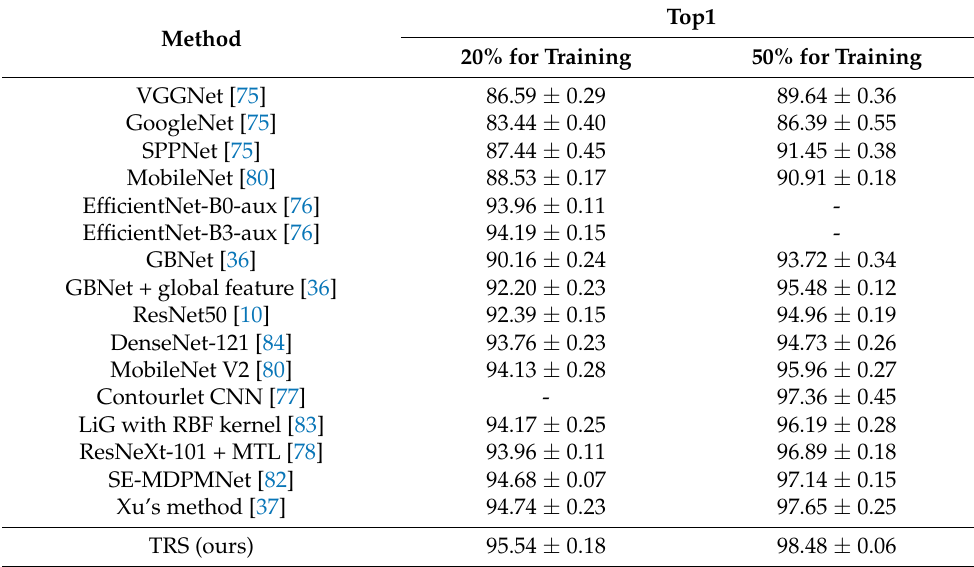
Table 4. Classification accuracy on AID